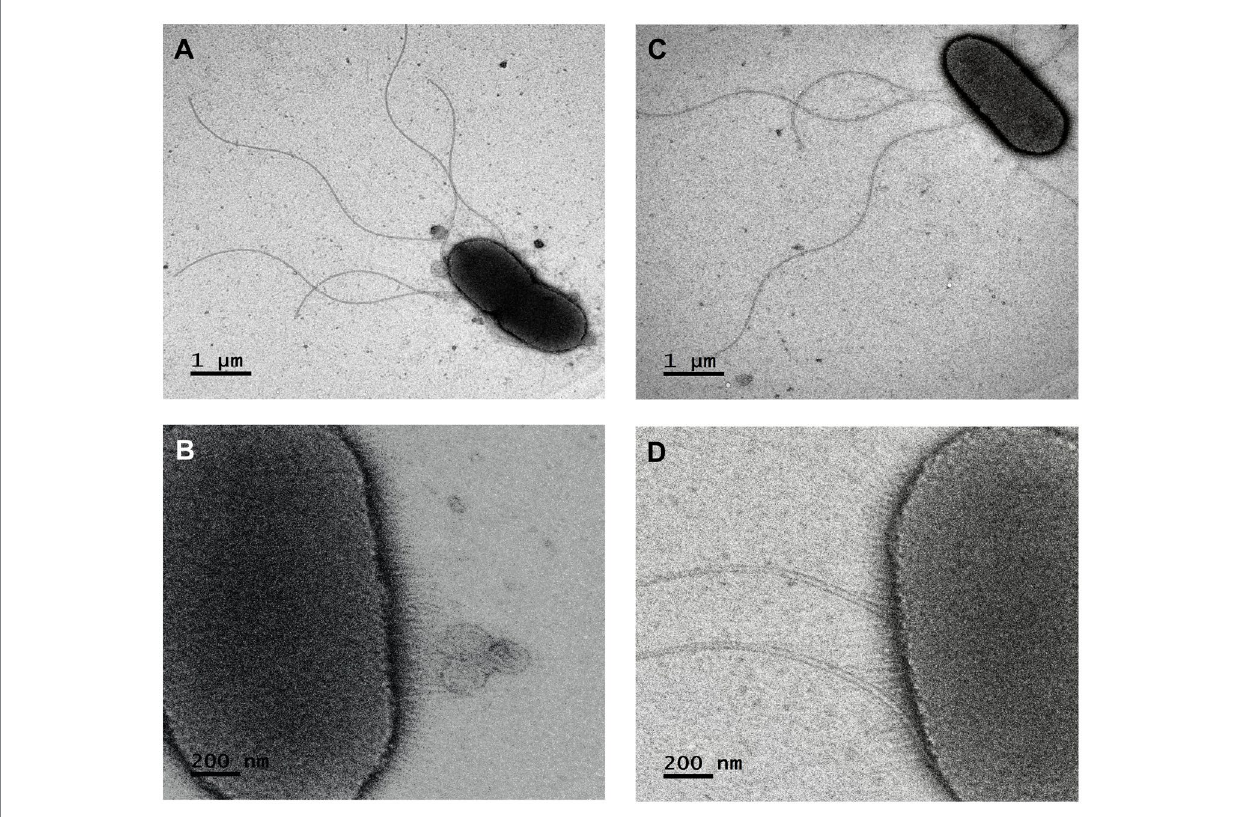
FIGURE 2 Scanning electron micrograph of the Rahnella contaminans ecotype. (A,B) flagella and fimbriae of strain ChDrAdgB13, and (C,D) of strain JaDmexAd06